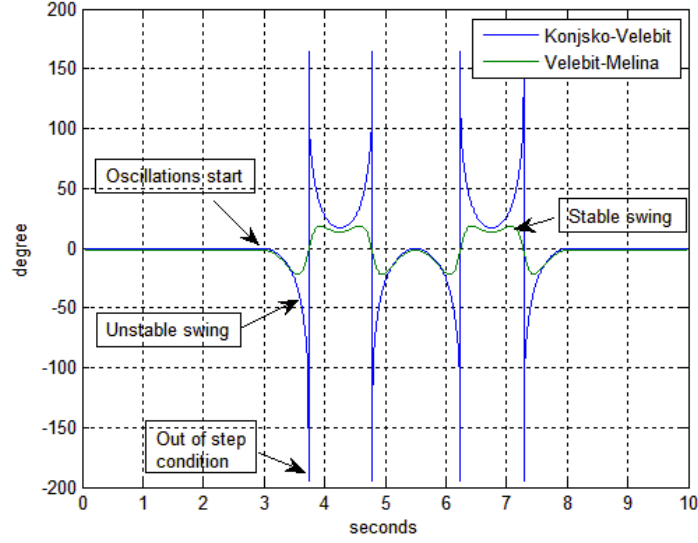
Figure 10. Voltage angle difference Δ φ , for two 400 kV transmission lines during out-of-step condition occurrence in the network.